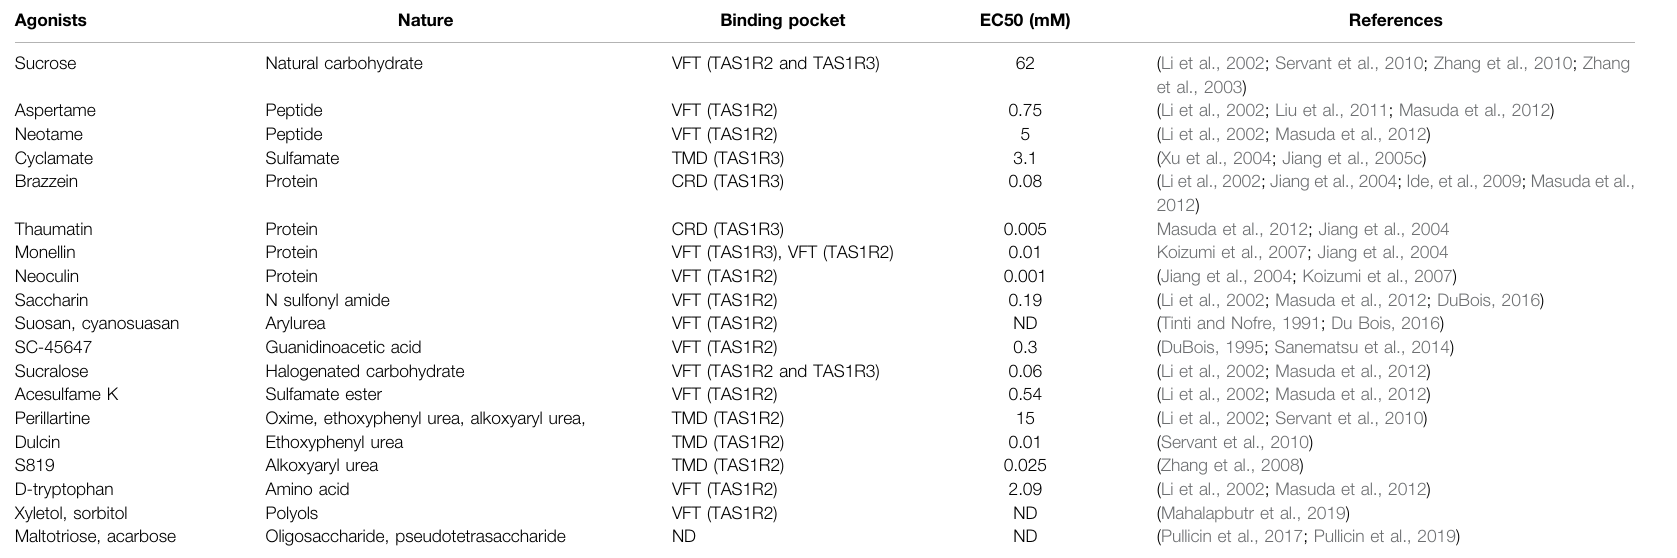
Where VFT, venus fl ytrap domain; TMD, transmembrane domain; ND, not